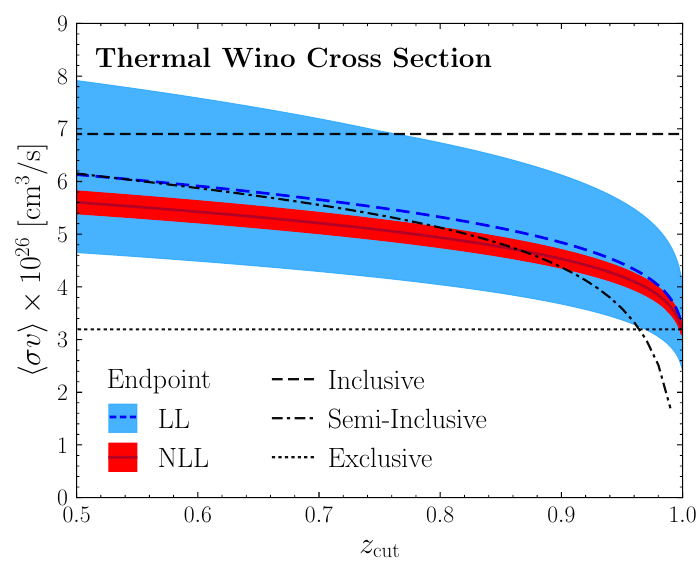
Figure 11 . A comparison of our LL and NLL calculations with inclusive, exclusive and semi- inclusive predictions from the literature. The best agreement is found with the semi-inclusive calculation. The disagreement as z cut 1 is due to unresummed logarithms of (1 z cut ) in the ! (cid:0) semi-inclusive calculation which are correctly captured using our